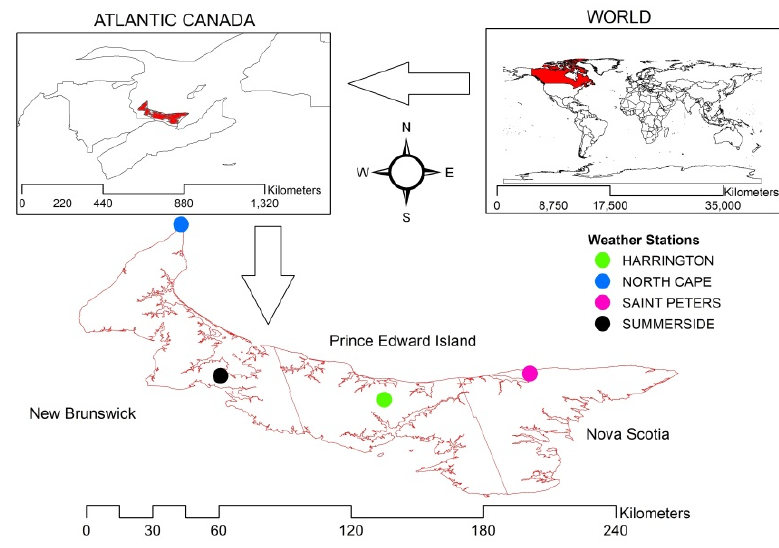
Figure 1. Locations of the four selected meteorological stations across Prince Edward Island, Canada.